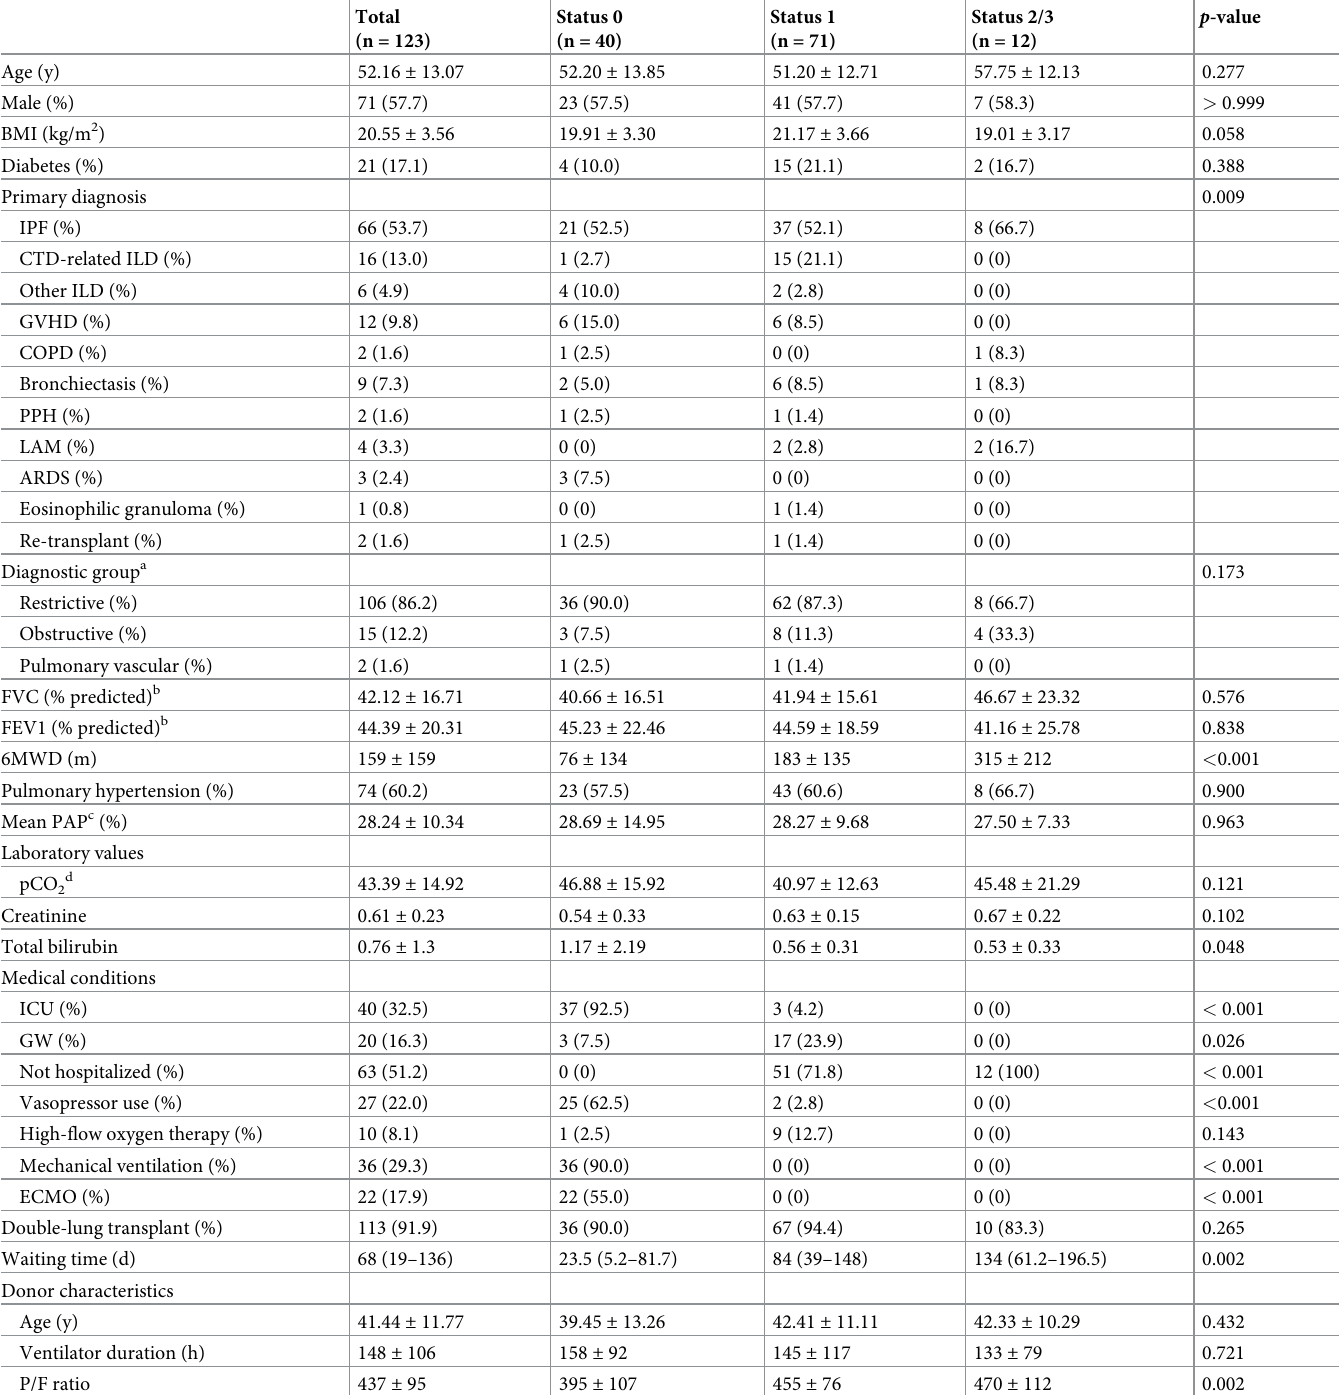
Table 2. Baseline patient characteristics at the time of